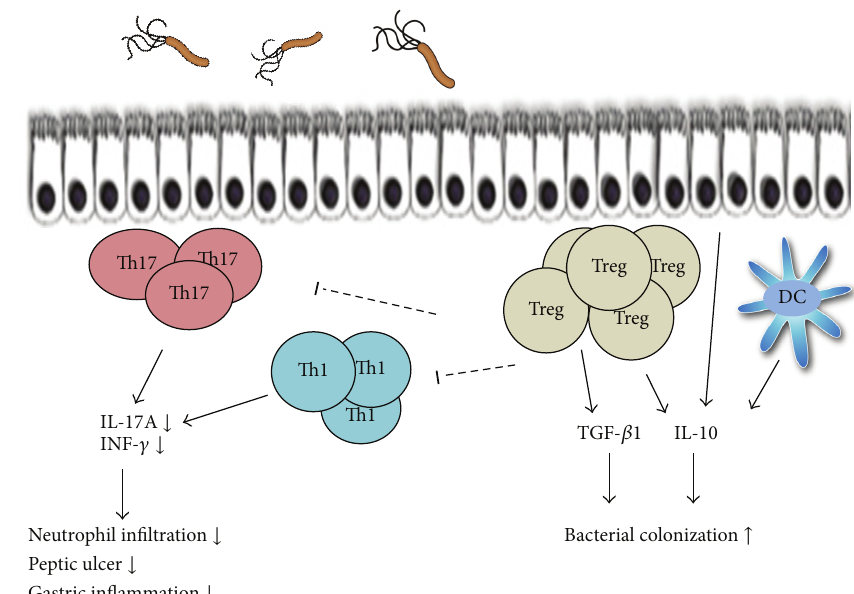
Figure 1: Diagram of how the Treg cell response may influence inflammation, bacterial colonization density, and occurrence of H. pylori - mediated